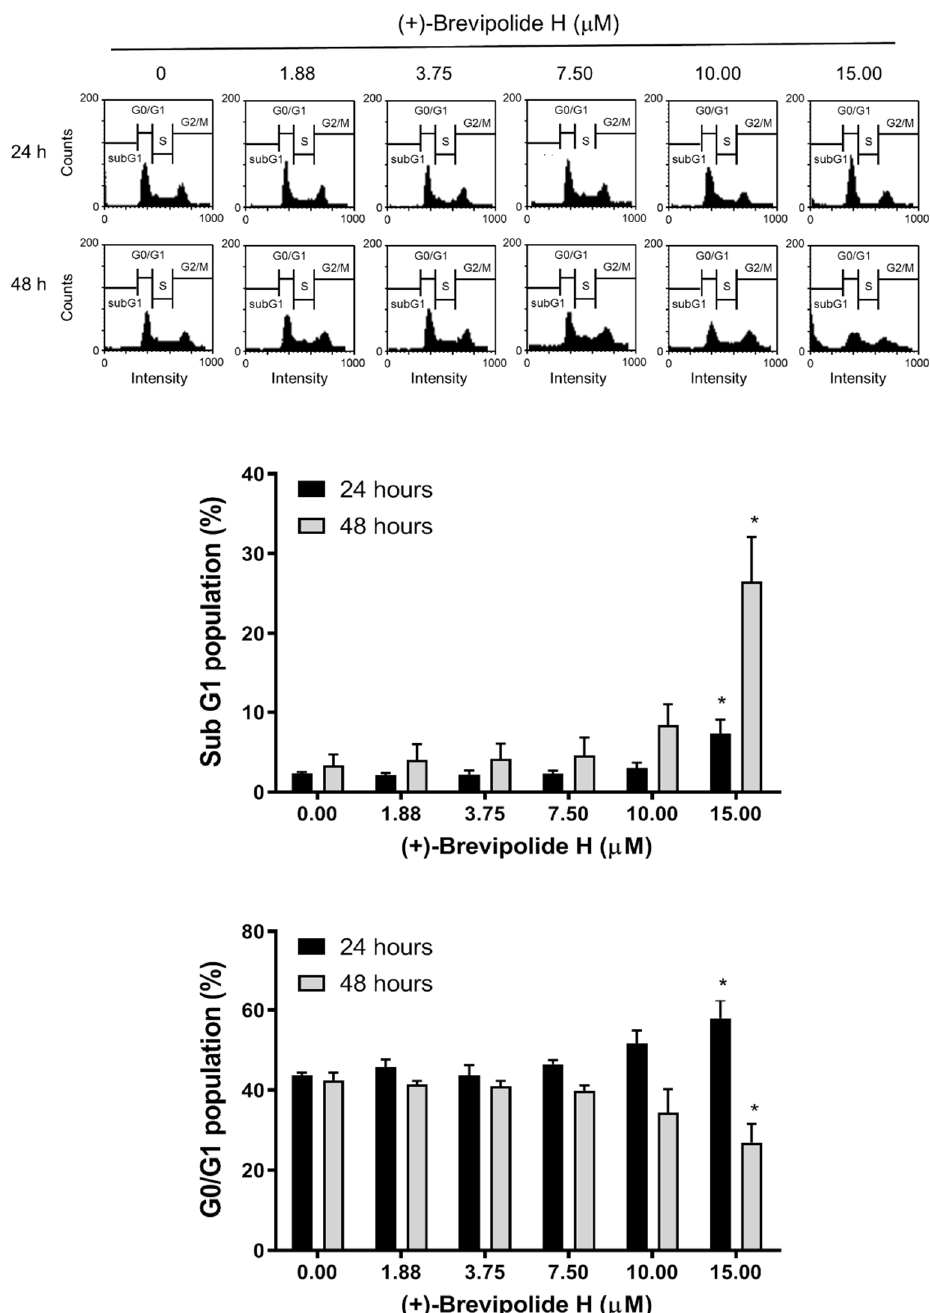
Figure 2. E ff ect of ( + )-brevipolide H on cell cycle distribution in PC-3 cells. The cells were incubated in the absence or presence of ( + )-brevipolide H for 24 or 48 h and then stained with propidium iodide. The distribution of cell population was examined using FACScan flow cytometric analysis. Quantitative data of cell population at both apoptotic sub-G1 and G0 / G1 were analyzed with BD CellQuest TM Pro Software. Data are expressed as mean ± SEM of three independent experiments; * p < 0.05 compared with the respective control.